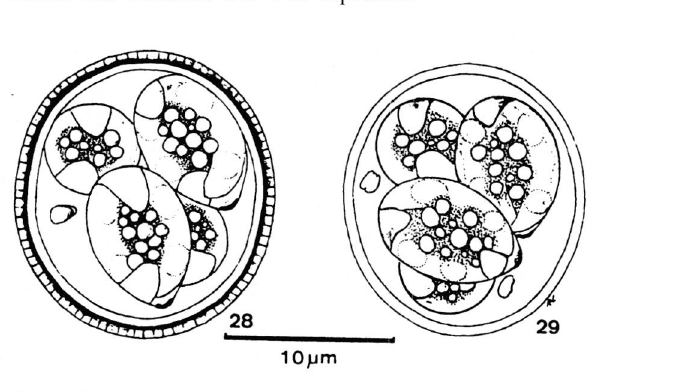
Figs 28, 29. - Line-drawings of mature oocysts of Eimeria bragan­ caensis n. sp., in faeces of the bat Peropteryx macrotis. Fig. 28. Oocyst with intact, two-layered wall. Fig. 29. Oocyst, having lost the thicker, outer striated wall